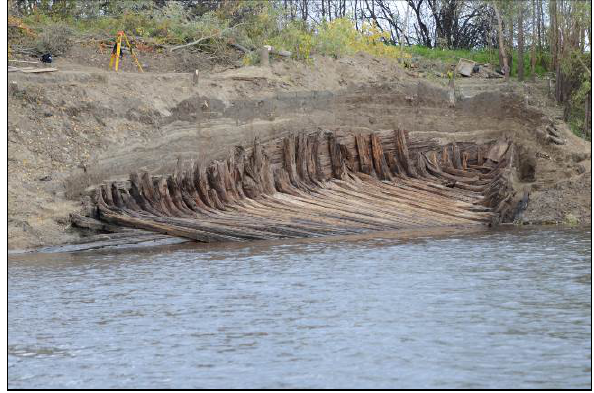
Figure 2. Kiryas ship after